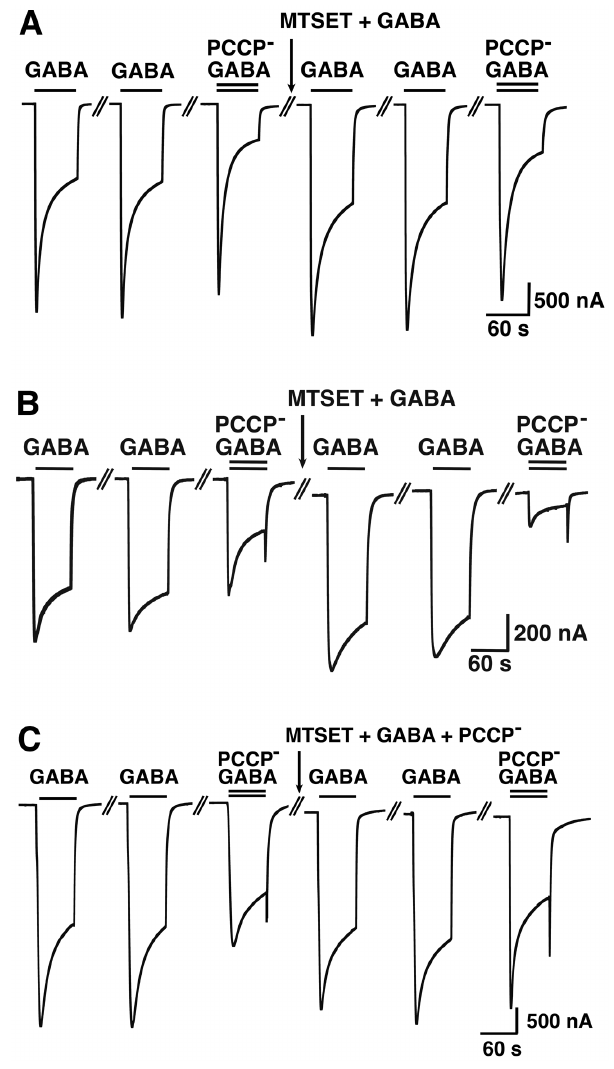
Figure 8. PCCP 2 prevents the increase in PCCP 2 sensitivity of a 1 V256 b 2 c 2 mediated by MTSET + + GABA. GABA (EC 10 ) was applied repetitively until a stable current response was observed followed by inhibition of the channel by PCCP 2 . Subsequently 5 mM MTSET was applied in the presence of GABA. After MTSET + treatment GABA was applied twice followed by a combined application of GABA and the same concentration of PCCP 2 used before. A, Wild type receptors were not affected by this treatment. B, The treatment leads to an enhanced inhibition in a 1 V256C b 2 c 2 . C, 5 mM MTSET + was applied to a 1 V256C mutant receptor in presence of GABA and 1 mM PCCP 2 . PCCP 2 prevented enhanced inhibition and therefore covalent reaction. These experiments were repeated independently three times using different